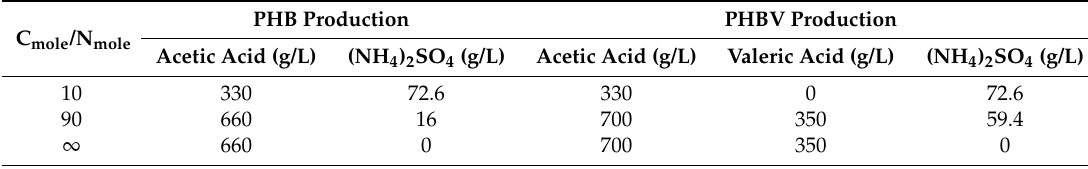
Table 1. Composition of pH-stat feeding solution for PHB and PHBV